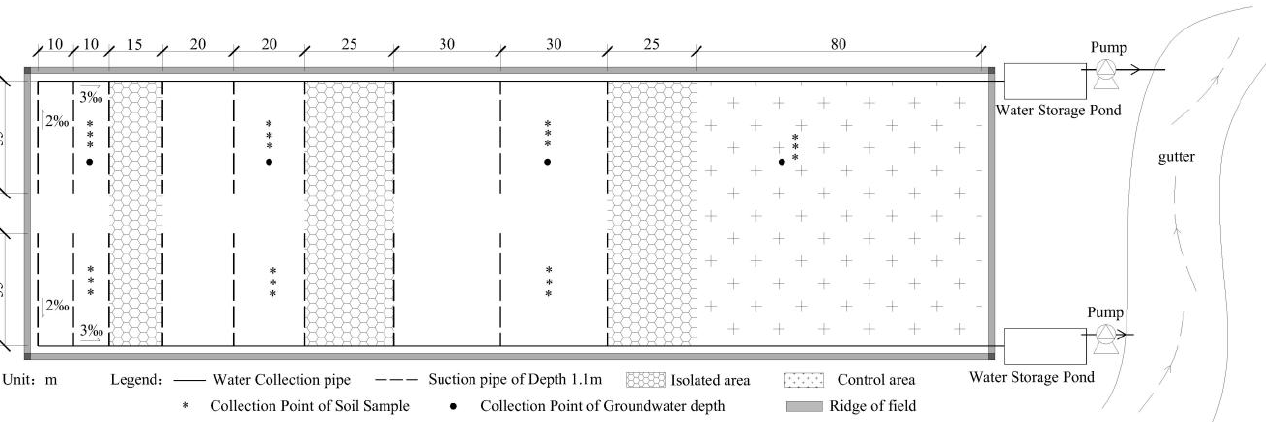
Figure 3. The drainage pipe layout and soil sampling point.